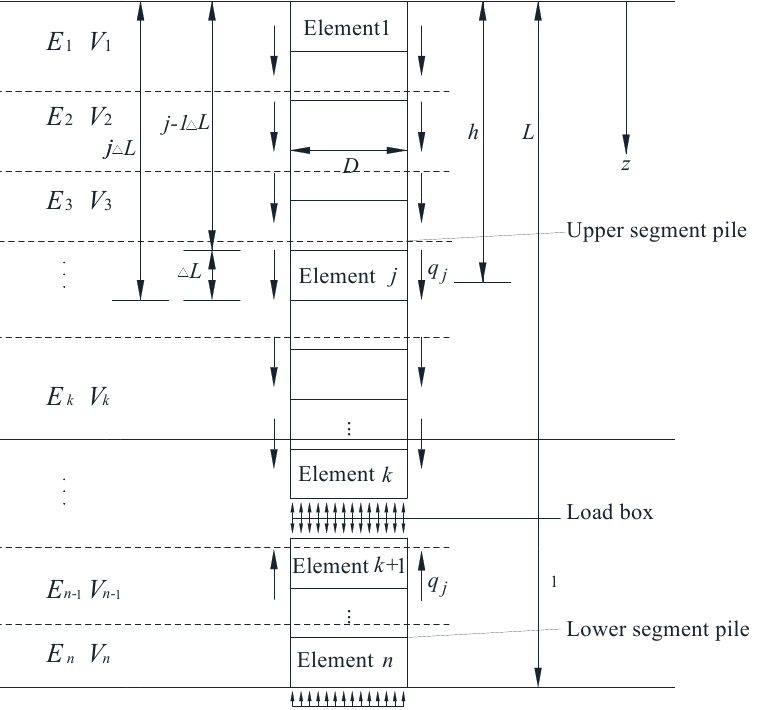
Figure 1. The geometry of the self-balanced pile.